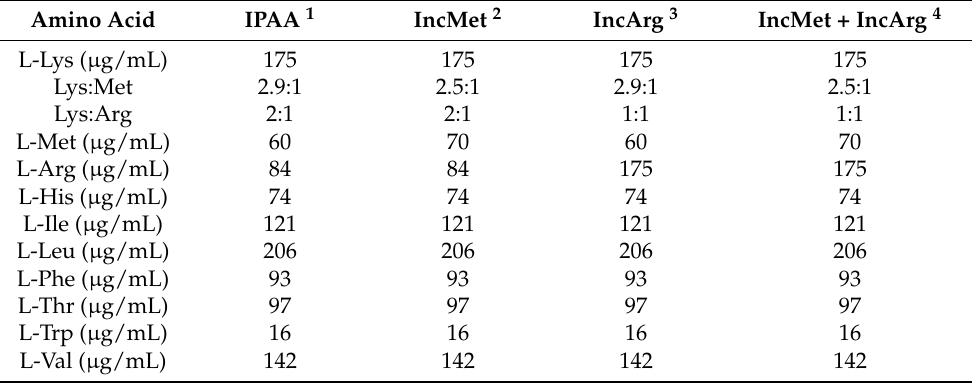
Table 1. Amino acid (AA) composition of the culture media with an ideal profile of AA (IPAA) and treatment media supplemented with greater amounts of Arg (incArg), Met (incMet), or both (incMet + incArg) to alter the ratio of Lys:Met and Lys:Arg relative to IPAA. Amino Acid IPAA 1 IncMet 2 IncArg